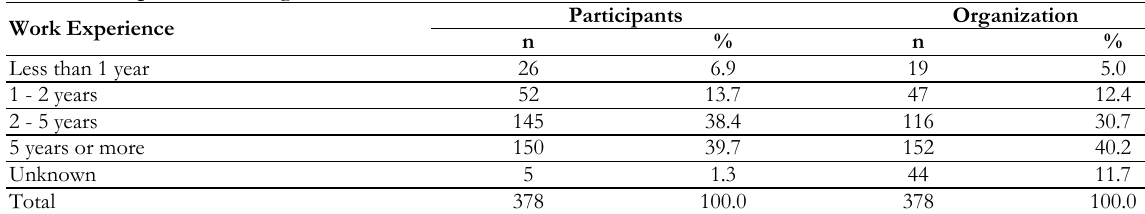
Table 2. Experience in Agile Methods